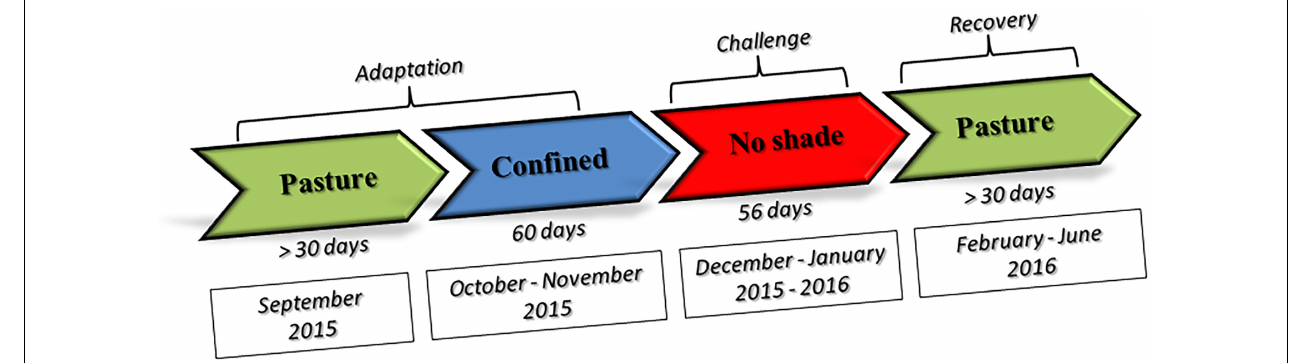
FIGURE 1 | Schematic representation of the experimental